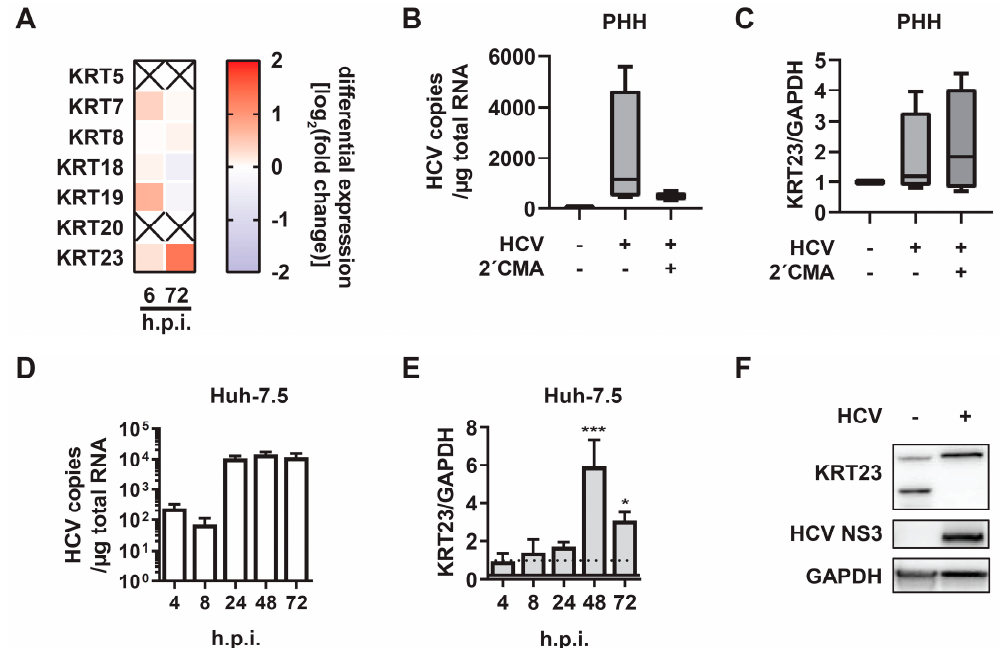
Figure 2. Keratin 23 is upregulated upon HCV challenge. ( A ) Heatmap of mRNA expression levels of keratins in primary human hepatocytes (PHH) upon HCV challenge (MOI 1). Shown are the mRNA expression levels of three independent donors 6 and 72 h post-infection. As a control for the differential gene expression, PHHs were treated with conditioned medium from Huh-7.5 cells and harvested at the same time points. ( B ) Comparison of HCV RNA copy numbers in primary human hepatocytes (PHHs) upon HCV infection (MOI 10) in the presence or absence of the polymerase inhibitor 2´CMA (10 μ M). PHHs were infected with either mock or HCV Jc1 WT in the presence of dimethyl sulfoxide or 10 mM of 2 ′ CMA and lysed 48 h post-infection. The HCV RNA copy numbers were determined by RT-qPCR and normalized to total RNA. ( C ) Comparison of KRT23 relative mRNA levels in mock-, HCV-infected (MOI 10), and 2 ′ CMA-treated (10 μ M) PHHs 48 hpi. KRT23 mRNA levels were normalized to GAPDH mRNA levels as determined by RT-qPCR. ( D ) Comparison of HCV RNA copy numbers in Huh-7.5 cells upon HCV infection (MOI 1). Huh-7.5 were left uninfected (mock) or infected with HCV Jc1 WT and lysed at the indicated time points. The HCV RNA copy numbers were determined by RT-qPCR and normalized to total RNA. ( E ) Analysis of KRT23 relative mRNA level induction in the time course of HCV infection (MOI 1). KRT23 mRNA levels were normalized to GAPDH mRNA levels as determined by RT-qPCR. The KRT23/GAPDH ratio of mock infected samples was arbitrarily set as one. ( F ) Western blot analysis of KRT23 protein levels in Huh-7.5 cells upon HCV challenge.